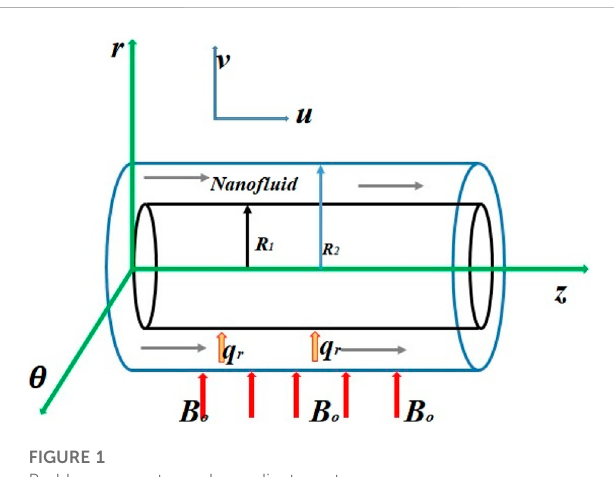
Problem geometry and coordinate